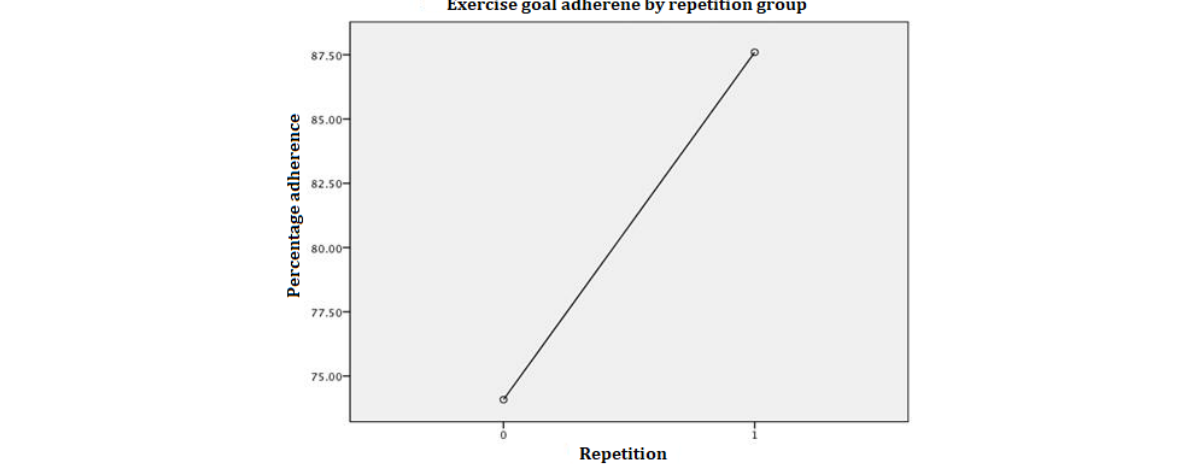
Figure 3. Repetition main effect.